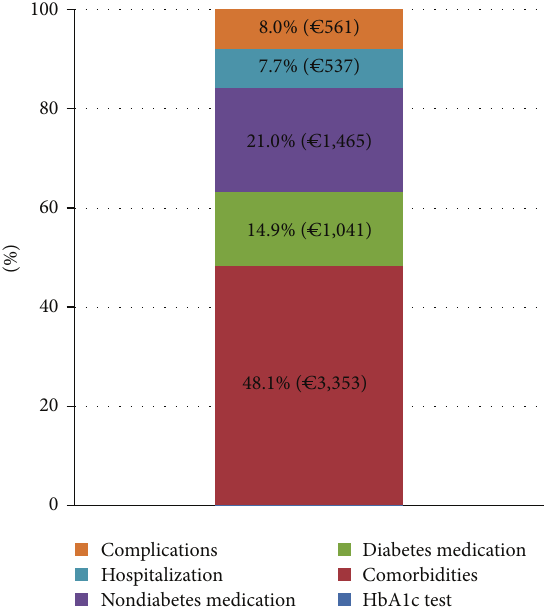
Figure 2: Breakdown of total cost of adequately versus inadequately controlled patients. Note: cost of HbA1c test is 0.2% of total cost in both subgroups; disability pensions are